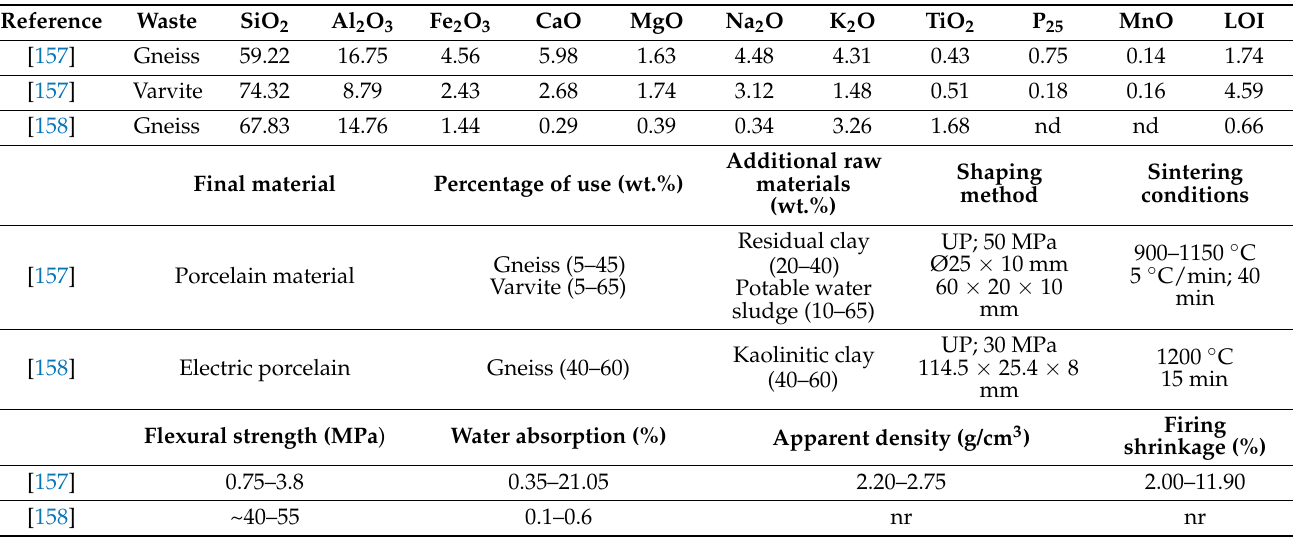
Table 27. Chemical composition (expressed wt.% oxide), processing parameters and technological properties of ceramic materials developed from gneiss and varvite